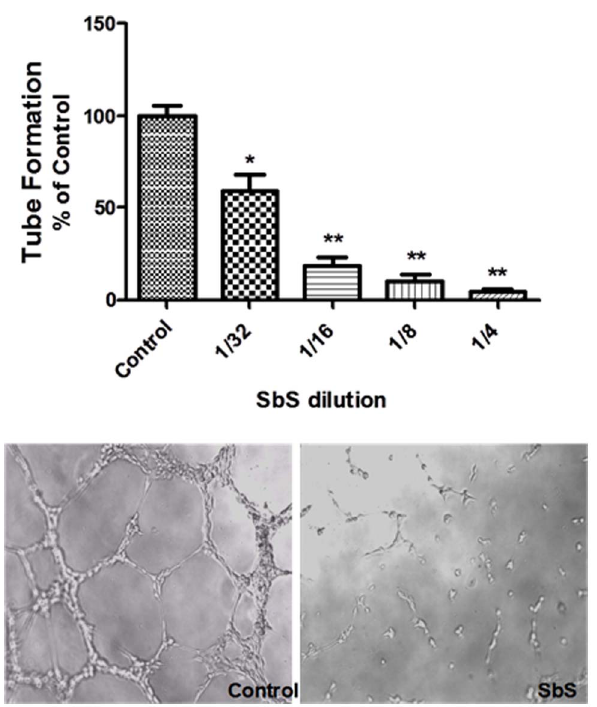
Figure 3. Sb inhibits HUVEC capillary tube formation. The ECMatrix TM in vitro angiogenesis assay was used to examine the effects of Sb on capillary tube formation. HUVEC ( , 1 6 10 4 cells) were cultured in 96-well plates previously coated with Matrigel and incubated for 16 hours at 37 u C in the absence or presence of different doses of SbS. Representative images of tubule formation in the control and SbS- treated groups are shown in the lower panel. Tubular structures were counted from 10 randomly selected images. Percentage (%) of control is the mean number of tubules expressed as a proportion of that in the control group. SbS significantly inhibited HUVEC tubule formation in a dose-dependent manner (*p , 0.05 for 1/32 dilution vs control; **p , 0.01 for 1/16, 1/8, 1/4 vs control). Bars represent mean 6